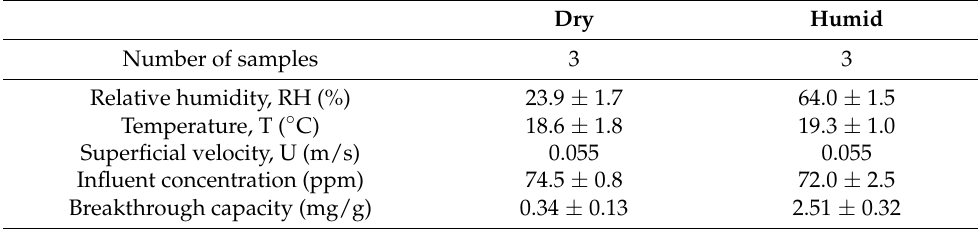
Table 2. Breakthrough capacities of the commercial